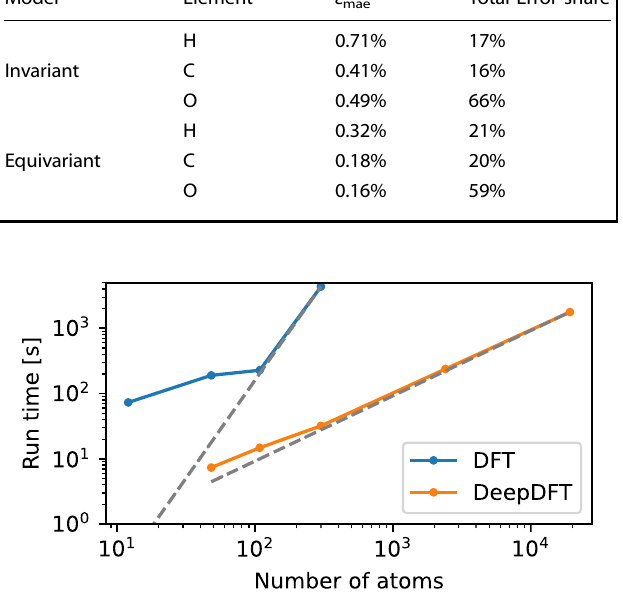
Fig. 7 Computation time for VASP running on 2*20 core Intel Skylake Xeon CPU vs DeepDFT running on a single RTX 3090 GPU. The dashed lines show the expected asymptotic behaviors ax 3 and ax